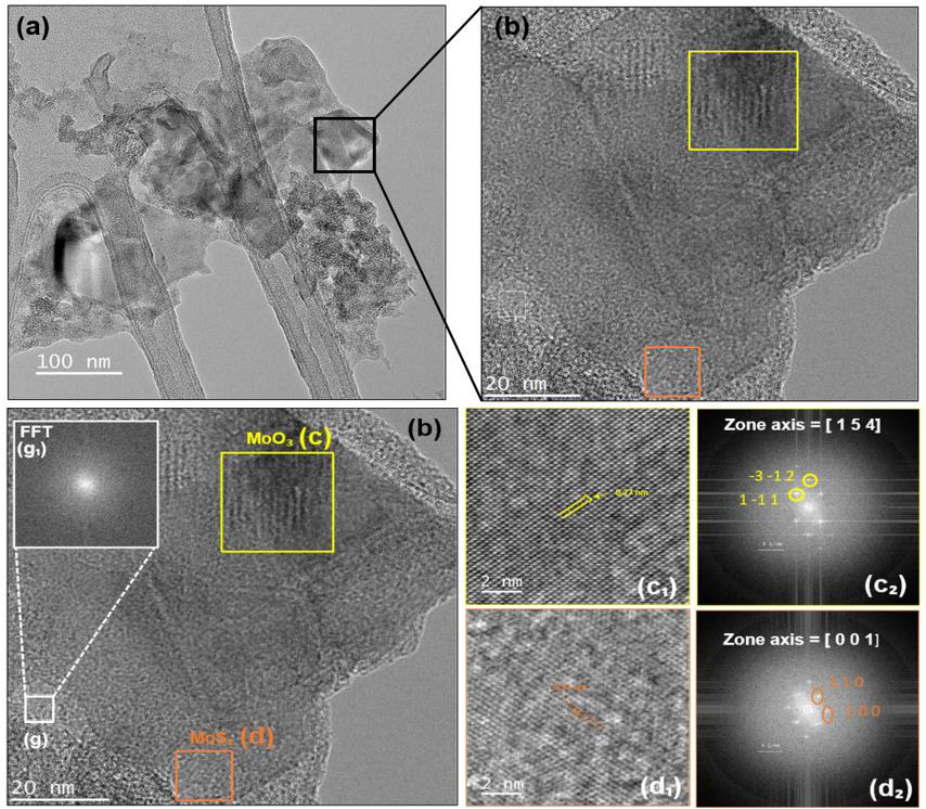
Figure 8. ( a ) HRTEM of MoO 3 :MoS 2 hybrid nanosheet; ( b ) high magnification image of MoO 3 :MoS 2 hybrid nanosheet. The ( c ) and ( d ) selected areas with their corresponding high magnification ( c 1 , d 1 ) and FFT ( c 2 , d 2 ) images indexed with JEMS software [42], respectively; ( g 1 ) FFT image of the selected area ( g ).